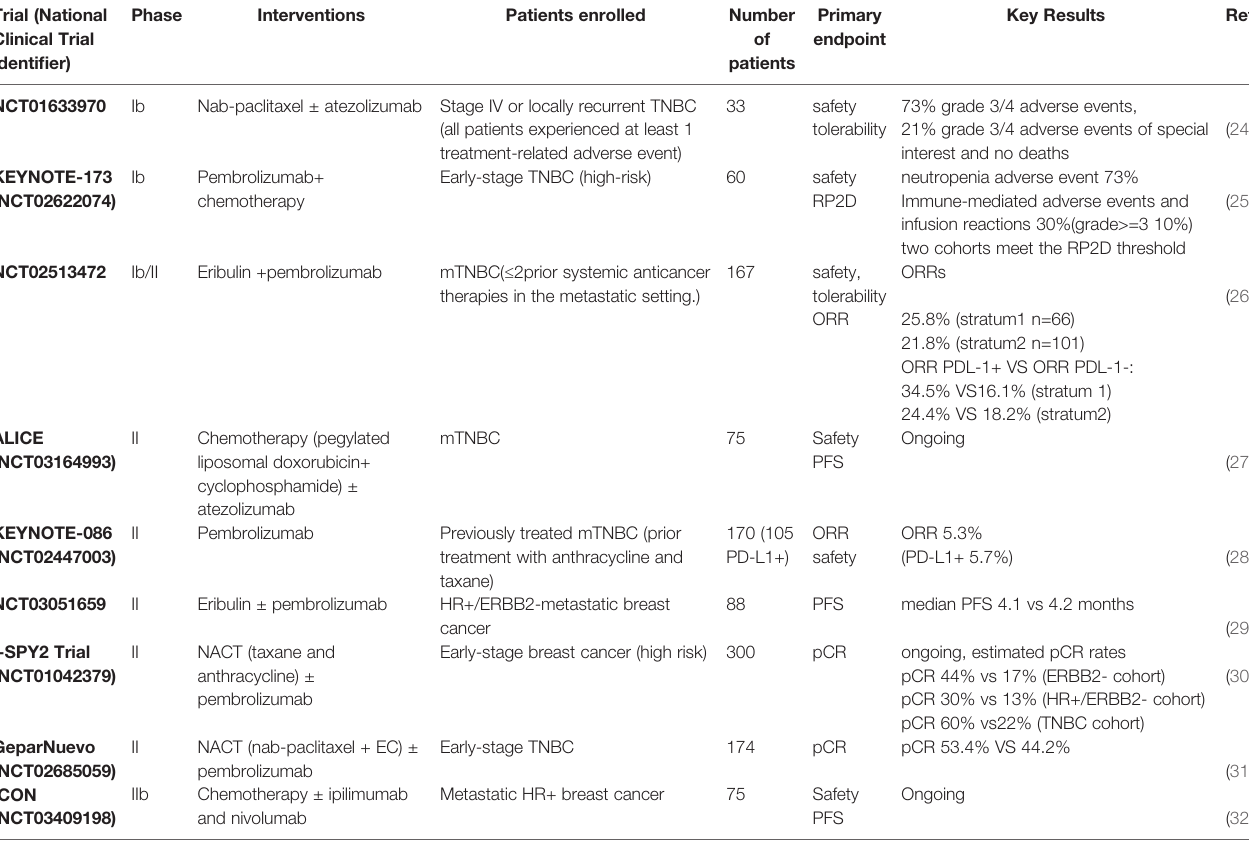
TABLE 2 | Summary of phase Ib/II clinical trials adding immunotherapy to chemotherapy in breast cancer. Trial (National Clinical Trial Identi fi